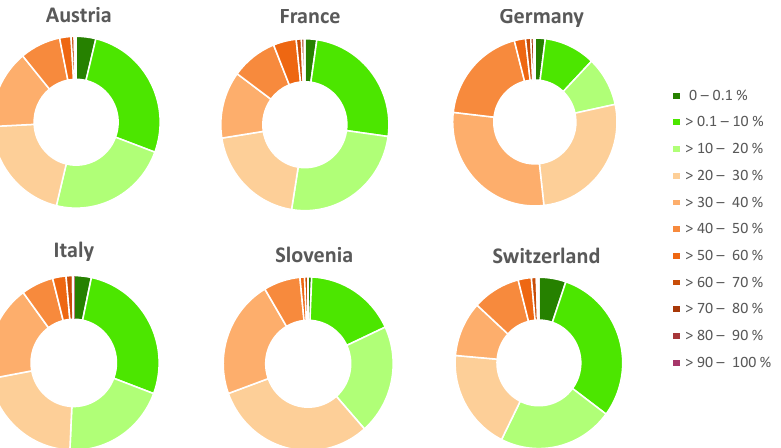
Figure 4. Comparison of the degree of infrastructure development for major countries (Monaco and Liechtenstein excluded) within the Alpine Convention perimeter (source: authors’